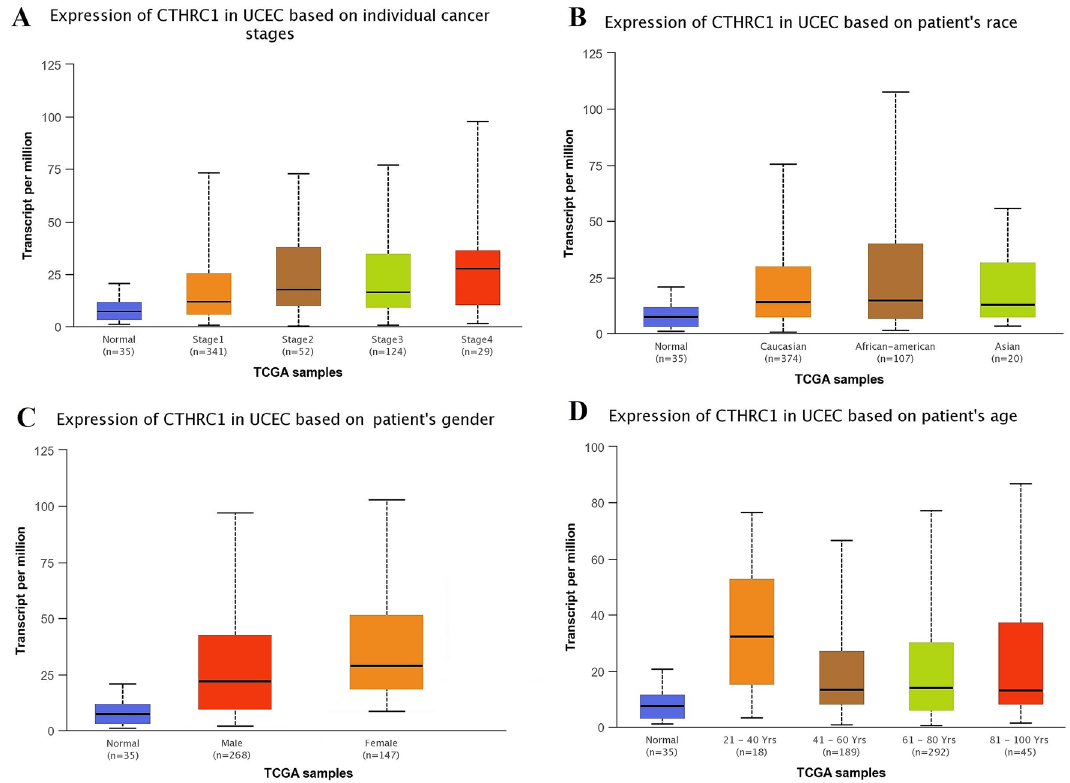
Figure 9. CTHRC1 transcription in various clinicopathological parameters of UCEC. ( A ) Different cancer stages based, ( B ) Different patients race based, ( C ) Different patients gender based, and ( D ) Different age groups based. A p-value of < 0.05 was selected as a cutoff